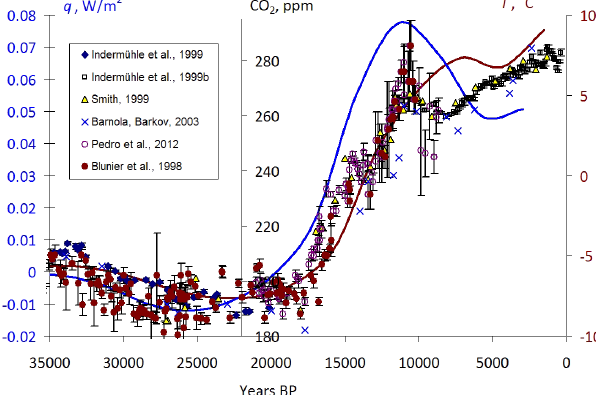
Figure 4. The comparison of GST history T ( t ) (brown line), SHF history q ( t ) (blue line) and CO 2 concentration in the Antarctic ice cores (multicoloured